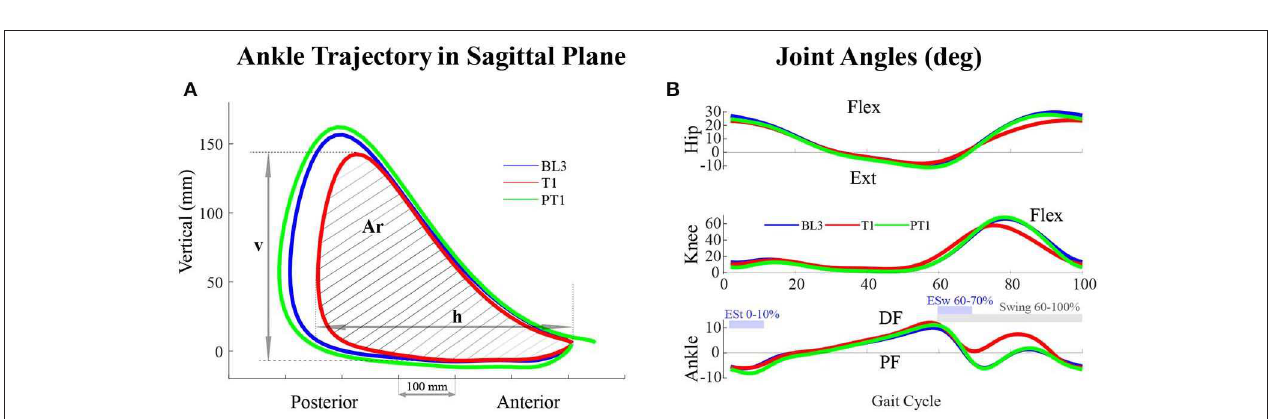
FIGURE 5 | (A) Ankle trajectory of the perturbed leg (right leg) in the sagittal plane of walking of a participant across sessions in Experiment I. The area enclosed within the trajectory (Ar) as well as the and horizontal (h) and vertical (v) spans decreased during the training (T1) session. (B) Joint angles of the perturbed leg of a participant across sessions in Experiment I. During the training (T1) session, the joint angles values vary with respect to baseline (BL3) and post-training (PT1) sessions. For the hip and knee joints, Flexion, Flex, is positive and Extension, Ext, is negative. For the ankle joint, Dorsiflexion, DF, is positive and Plantarflexion, PF, is negative.